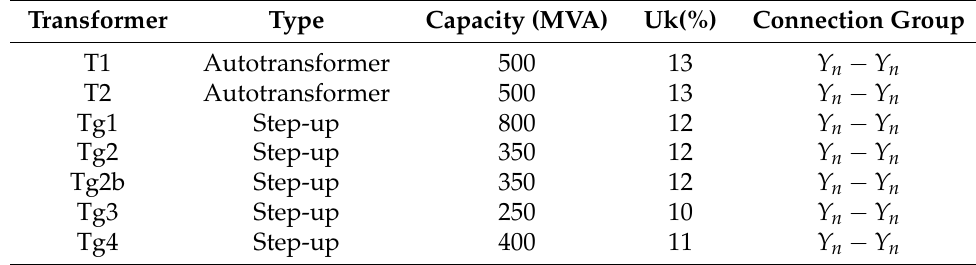
Table A2. Transformer data of the utility grid.